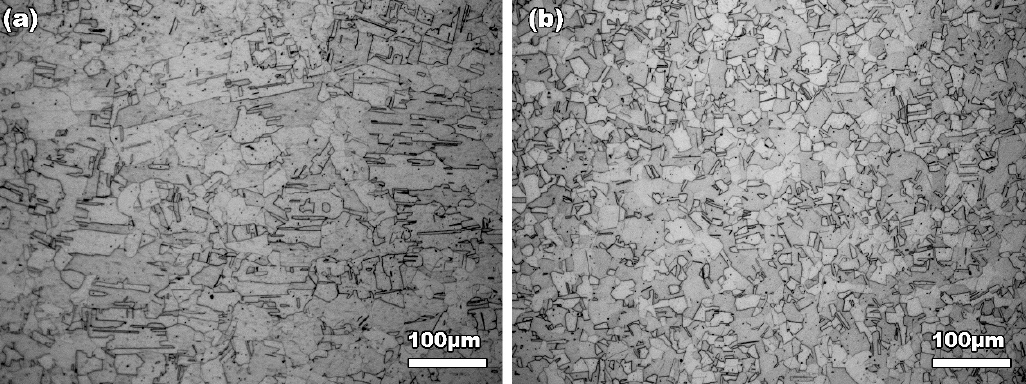
Figure 1. Metallographic structure of the ( a ) 90/10 and ( b ) 70/30 copper–nickel tubes used in this work.